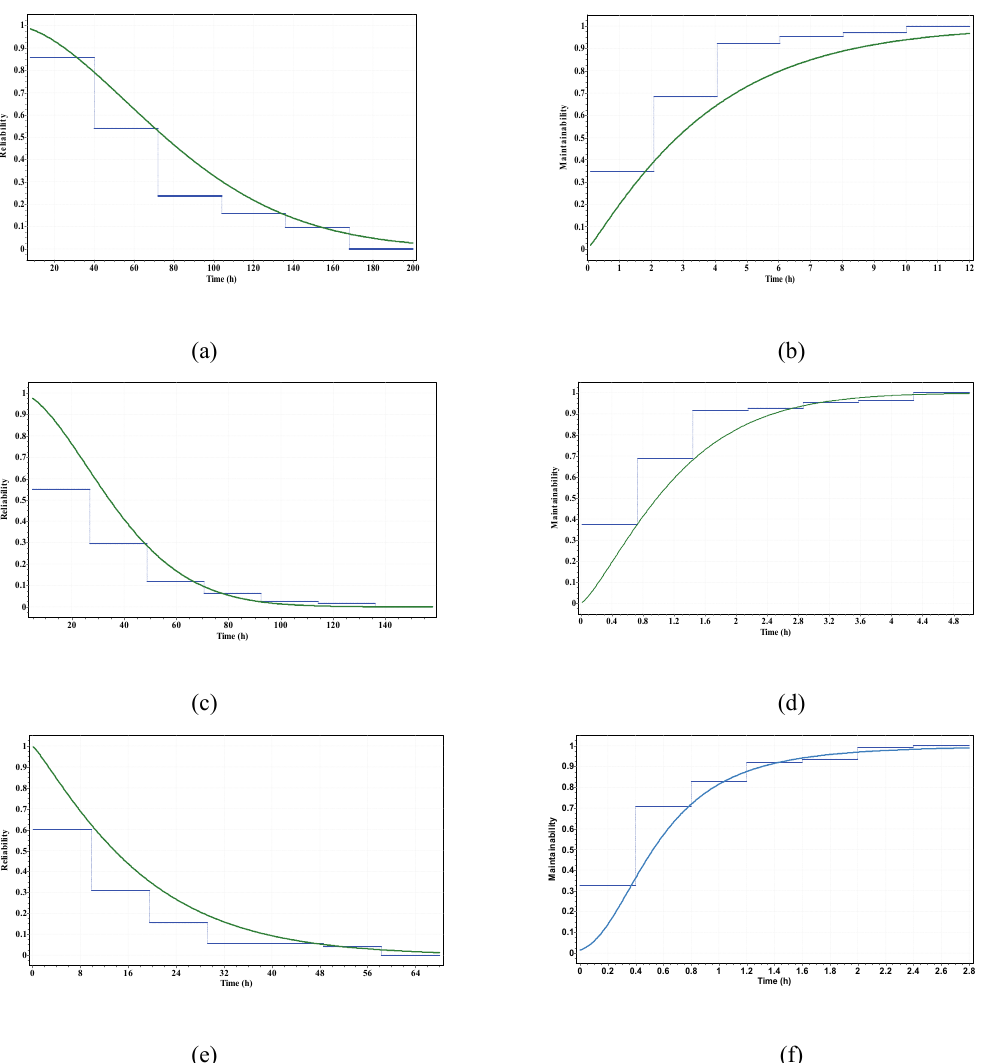
Fig. 5 Reliability and maintainability plots of the PSW machines